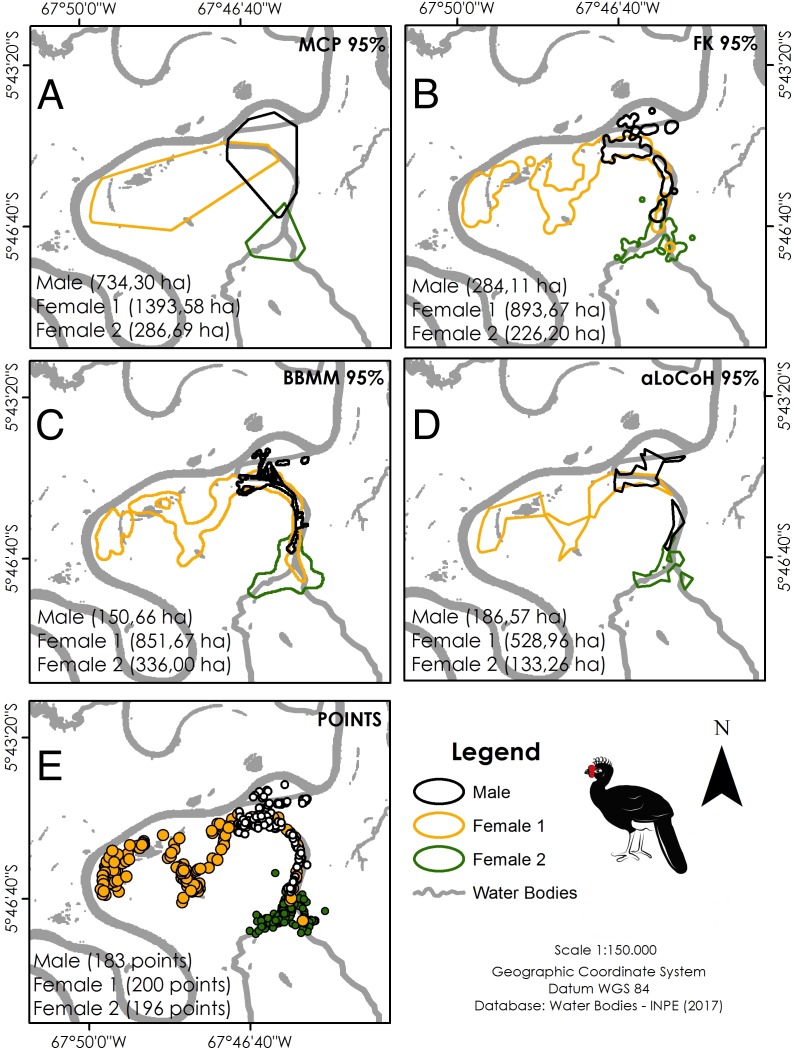
Home range size of the three monitored individuals of C. globulosa in the Médio Juruá, Amazonas, Brazil, using multiple estimators.(A) Minimum Convex Polygon (95% MCP). (B) Fixed Kernel (95% FK). (C) Brownian Bridge Movement Model (BBMM 95%). (D) Adaptive Local Convex Hull (aLoCoH 95%). (E) Locations of all individuals.